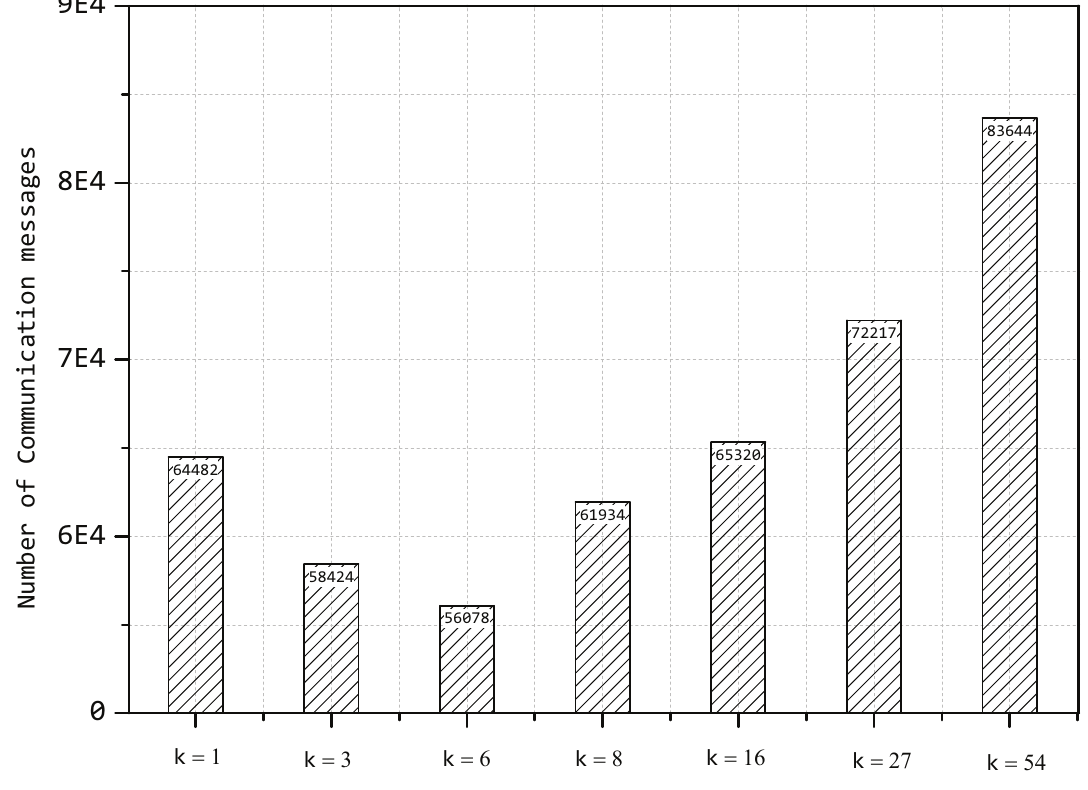
Figure 14. Number of communication messages with different values of k